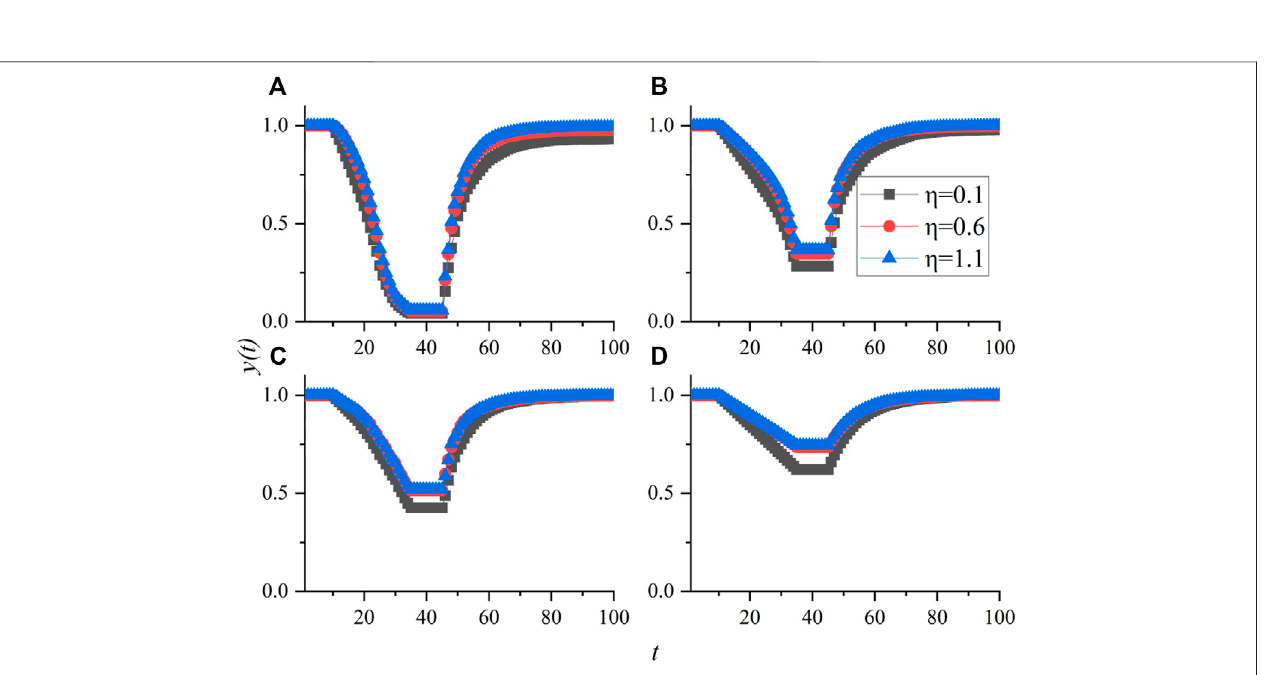
Frontiers in Physics |